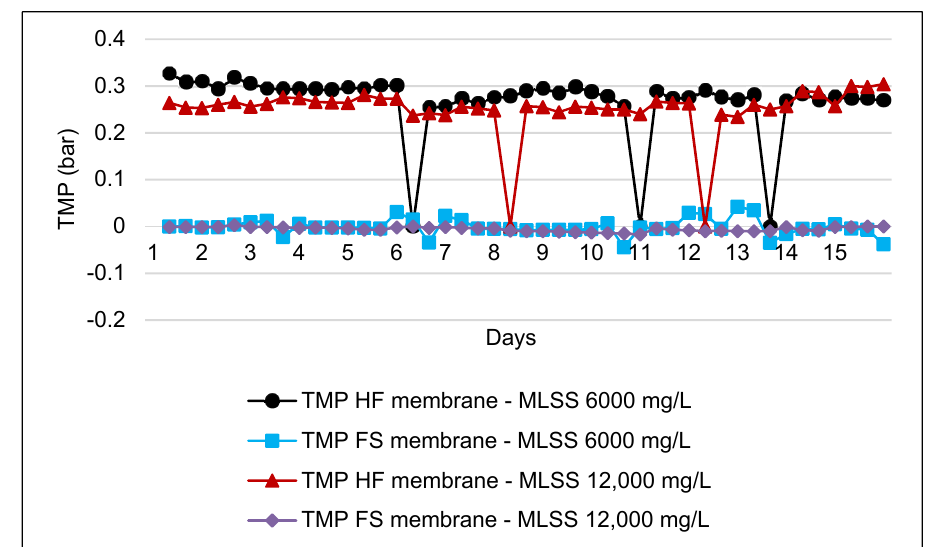
Figure 7. TMP trend for HF and FS membranes by using MLSS values of 6000 mg/L and 12,000 mg/L.